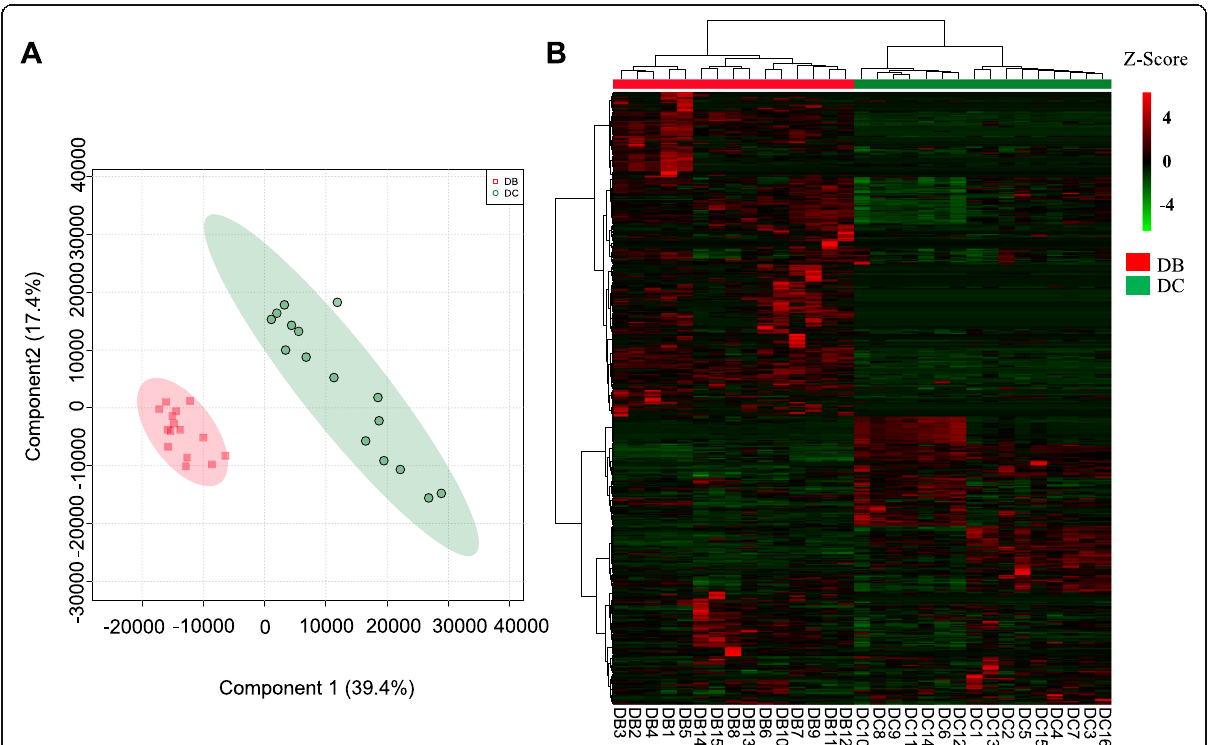
Fig. 3 Rumen resistome profiles in dairy cows and dairy buffaloes. A The principal component analysis of ARGs identified in the rumen of dairy cows and dairy buffaloes. B The heatmap of the relative abundance of all the ARGs in all the